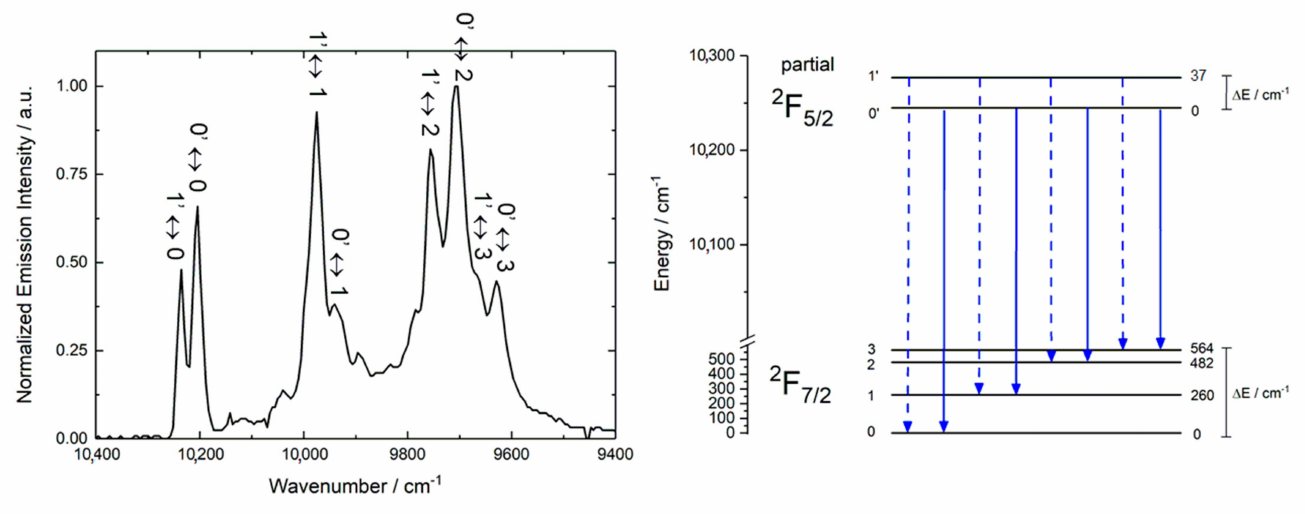
Figure 4. ( Left ) Solid-state emission spectrum of 1 recorded at 10 K under excitation of 22,220 cm − 1 (450 nm) with the proposed transitions between the crystal field sublevels of the 2 F 5/2 → 2 F 7/2 emission band. ( Right ) Energy diagram of the 2 F 2 F 5/2 excited state and 7/2 ground state obtained from the solid-state emission spectrum measured at 10